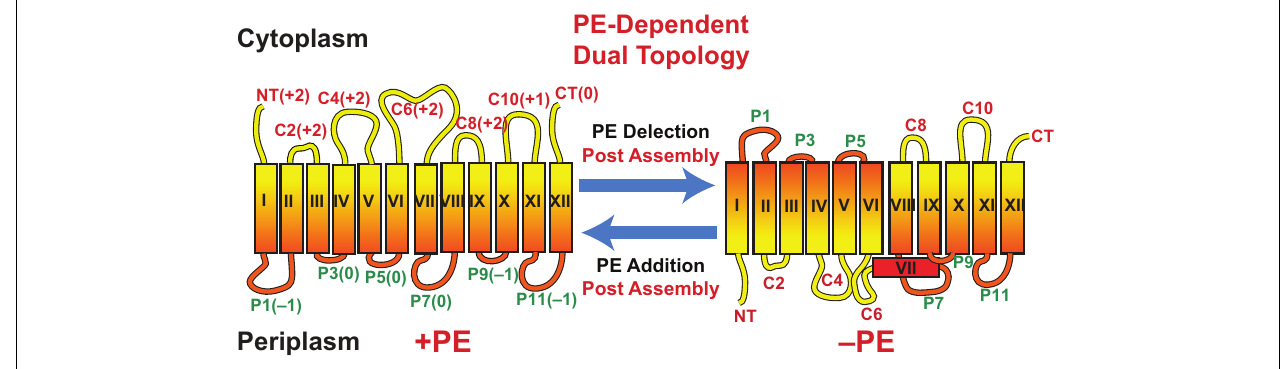
FIGURE 3 | Topological organization of LacY as a function of membrane lipid composition. TMDs (Roman numerals) and EMDs (Arabic numerals) are sequentially numbered from the N-terminus to C-terminus with EMDs exposed to the periplasm (P) or cytoplasm (C) as in wild type cells. Net charge of EMDs is shown. Topology of LacY is shown after initial assembly in PE-containing cells (+PE) or after initial assembly in PE-lacking cells (–PE). The interconversion of topological conformers and the ratio of native to inverted conformer are reversible in both directions depending on the dynamic level of PE in membranes. Figure was modified and legend reprinted by permission from Springer Nature (Dowhan et al., 2017): Copyright